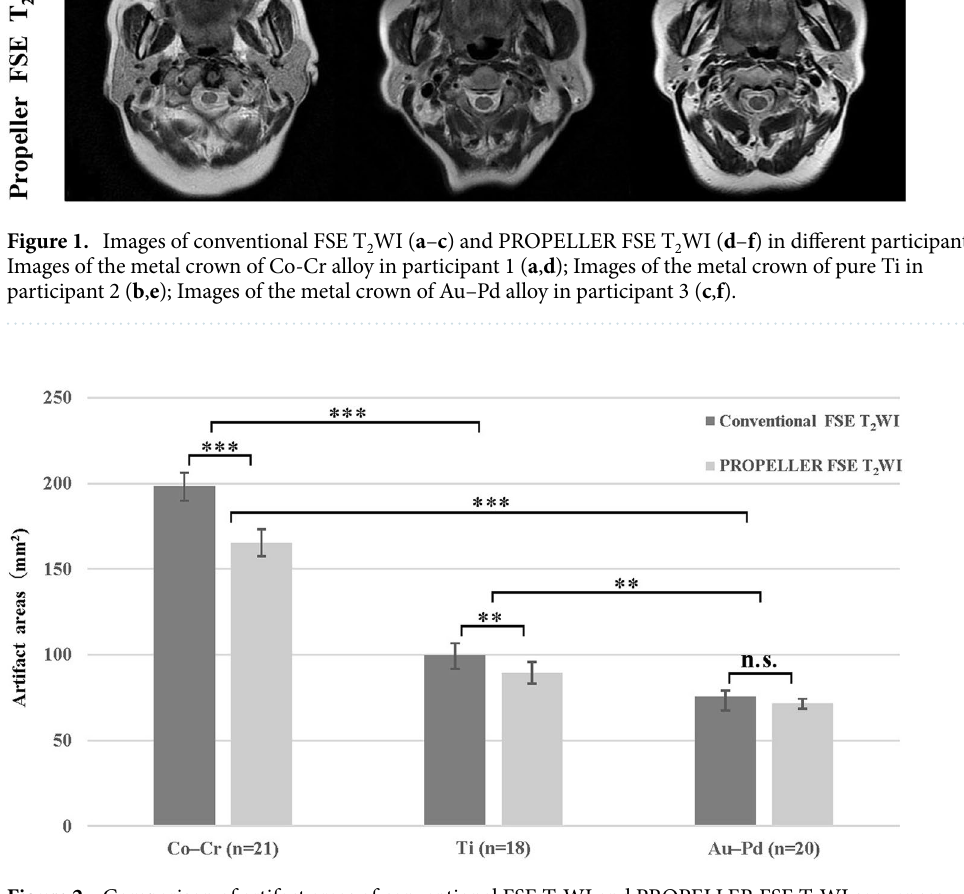
Figure 2. Comparison of artifact areas of conventional FSE T 2 WI and PROPELLER FSE T 2 WI sequences caused by the different PFM crowns. n.s, not significant; **, P < 0.01; ***, P <